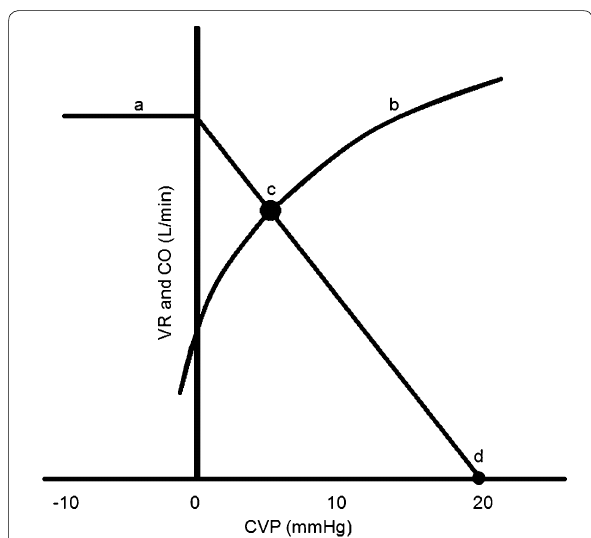
Fig. 1 The venous return curve ( a ) combined with the cardiac output curve ( b ). The intersection of these two curves ( c ) is the working point of the circulation. The central venous pressure when venous return equals zero is the P mcf ( d ). The slope of the V R is determined by the resistance to venous